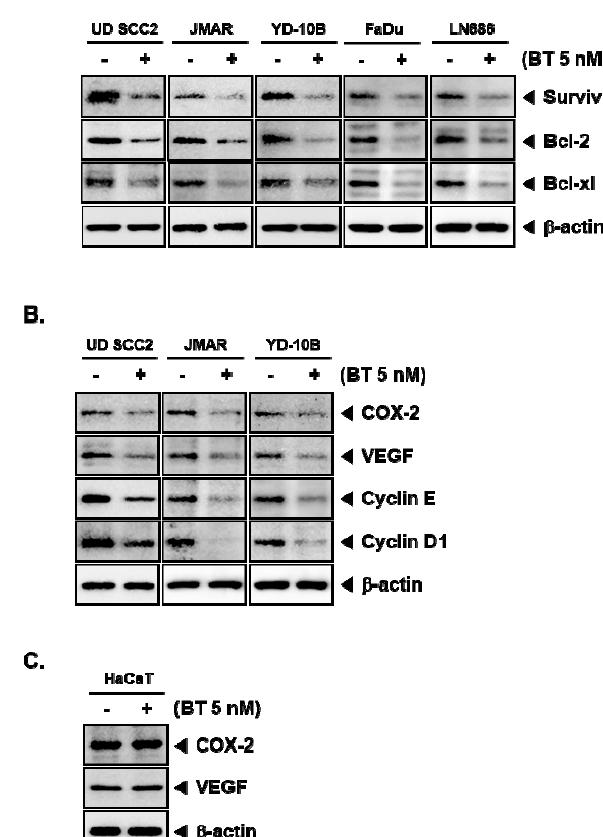
Figure 3. BT suppresses the STAT3-regulated target genes. ( A ) HNSCC cells (UD SCC2, JMAR, YD-10B, FaDu, and LN686) were treated with 5 nM of BT for 48 h and western blotting was performed Survivin, Bcl-2, Bcl-xl; ( B ) COX-2, VEGF, Cyclin E, and Cyclin D1 and western blotting was done. β -actin was used as an input control to verify equal protein loading. ( C ) HaCaT cells were treated with 5 nM of BT for 48 h and western blotting was performed COX-2 and VEGF. β -actin was used as an input control to verify equal protein